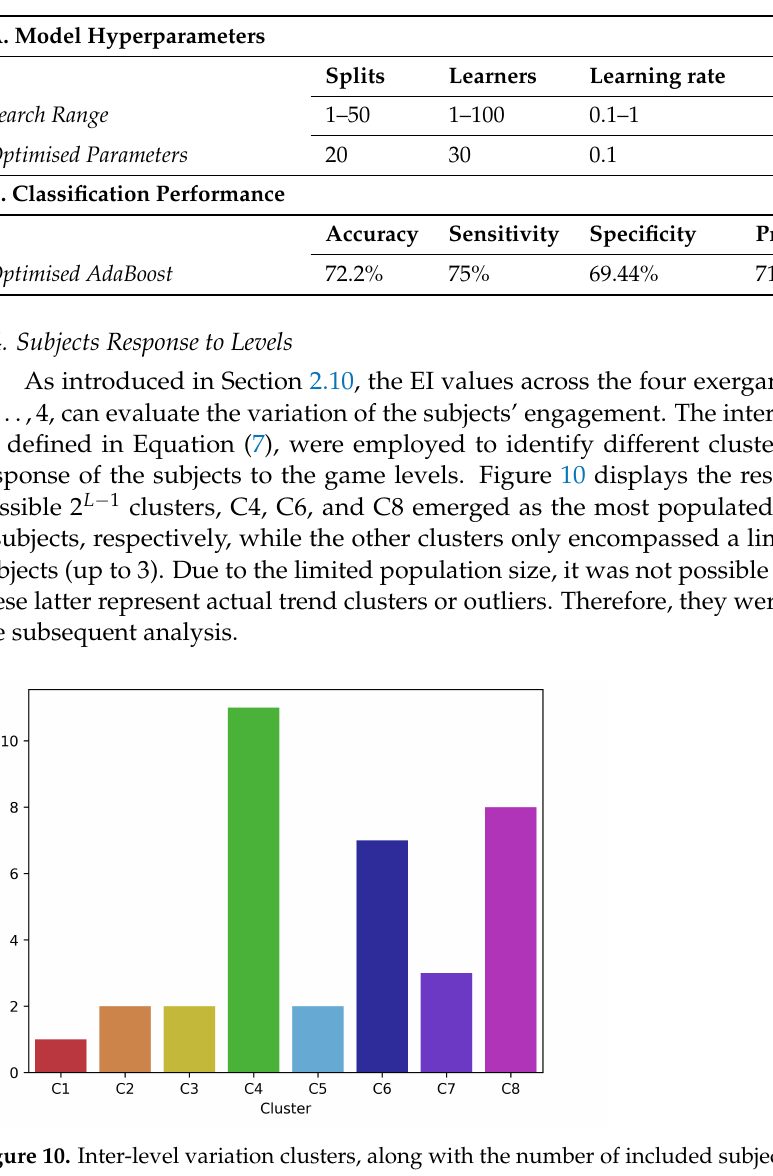
Table 9. AdaBoost classifier (Low-Engagement vs. High-Engagement): model hyperparameters and classification performance.